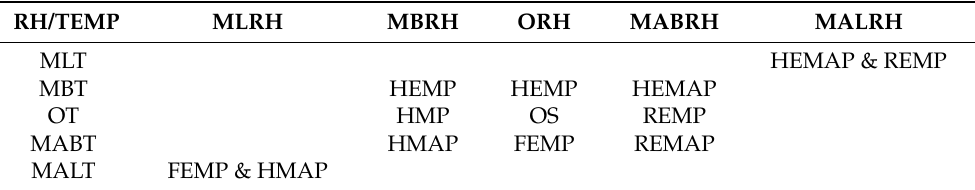
Table 3. Fuzzy associative